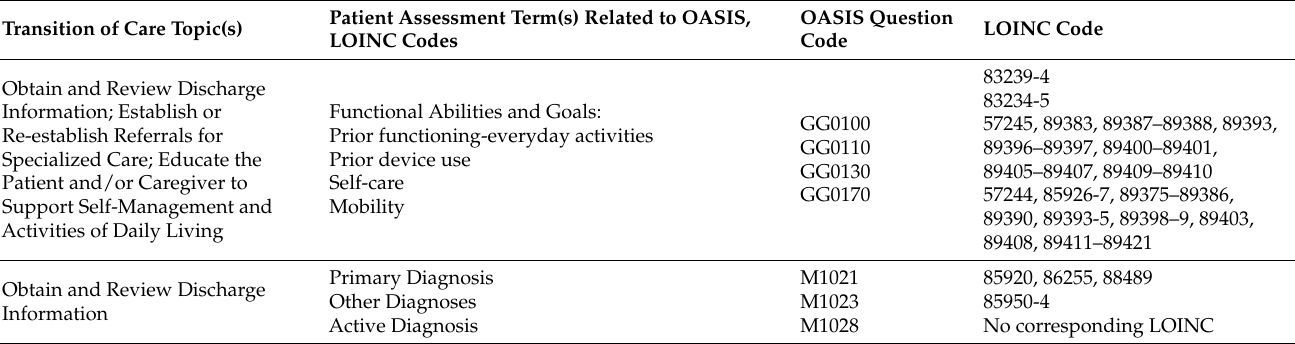
Figure 2. Sankey Diagram Illustrating Linkages Among Transition of Care Topics, OASIS Concepts, and LOINC Codes.